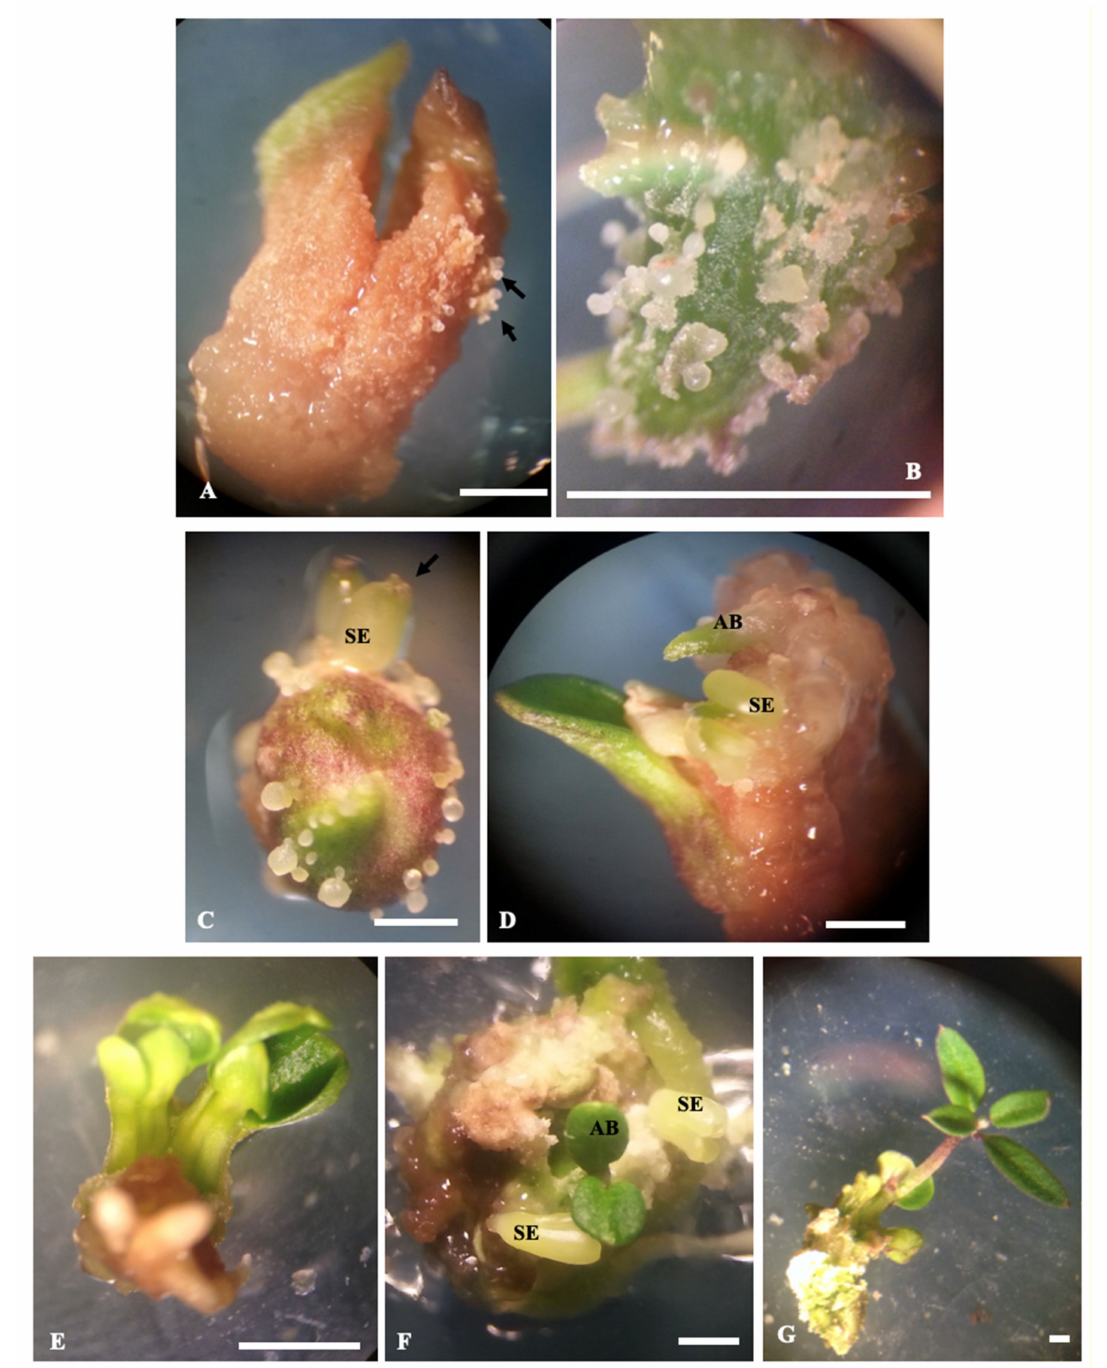
Figure 3. Secondary embryogenesis and adventitious bud formation during somatic embryo germination. ( A ) and ( B ) Beginning of development of globular secondary embryos (arrows) from the primary ones, ( C ) Secondary embryos at globular and heart-shaped (arrow) stages, ( D ) Beginning of development of an adventitious bud, ( E ) Adventitious buds, ( F ) Heart-shaped secondary embryos and adventitious buds, ( G ) Adventitious bud singled out from a primary somatic embryo by using a scalpel. AB—Adventitious bud. SE—somatic embryo. Bars correspond to 1